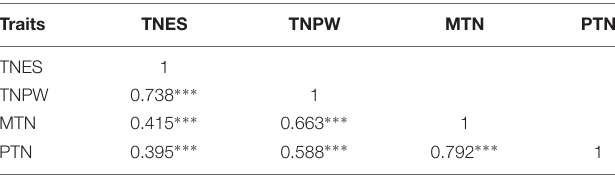
TABLE 1 | Correlation coefficient among various tiller number-related traits in RIL population. Traits TNES